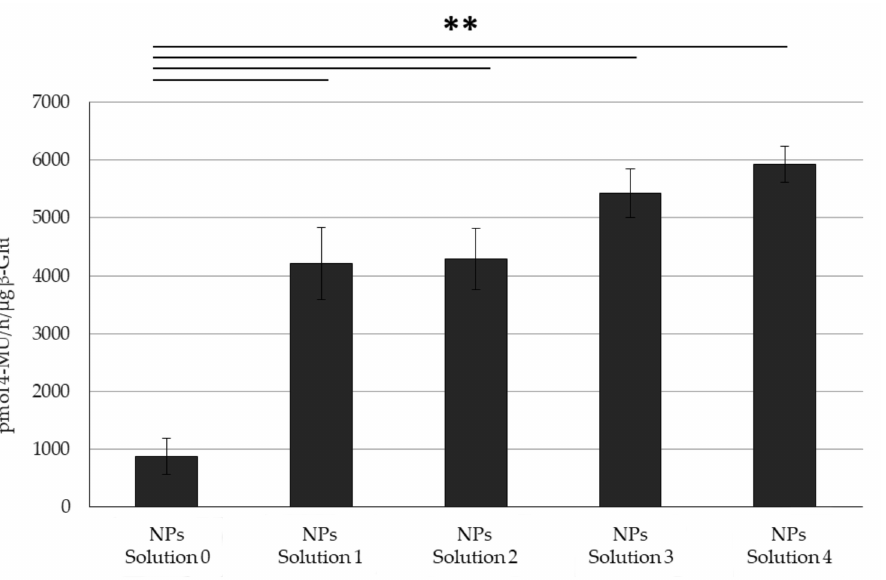
Figure 4. Activity Comparison. Activity of Tween ® 20: β -Glu solutions at different molar ratios (Solutions 1-4) and encapsulated into PLGA NPs. Statistical analysis was performed using the Student t test where ** p < 0.01 and N = 3 individual NP formulations of each